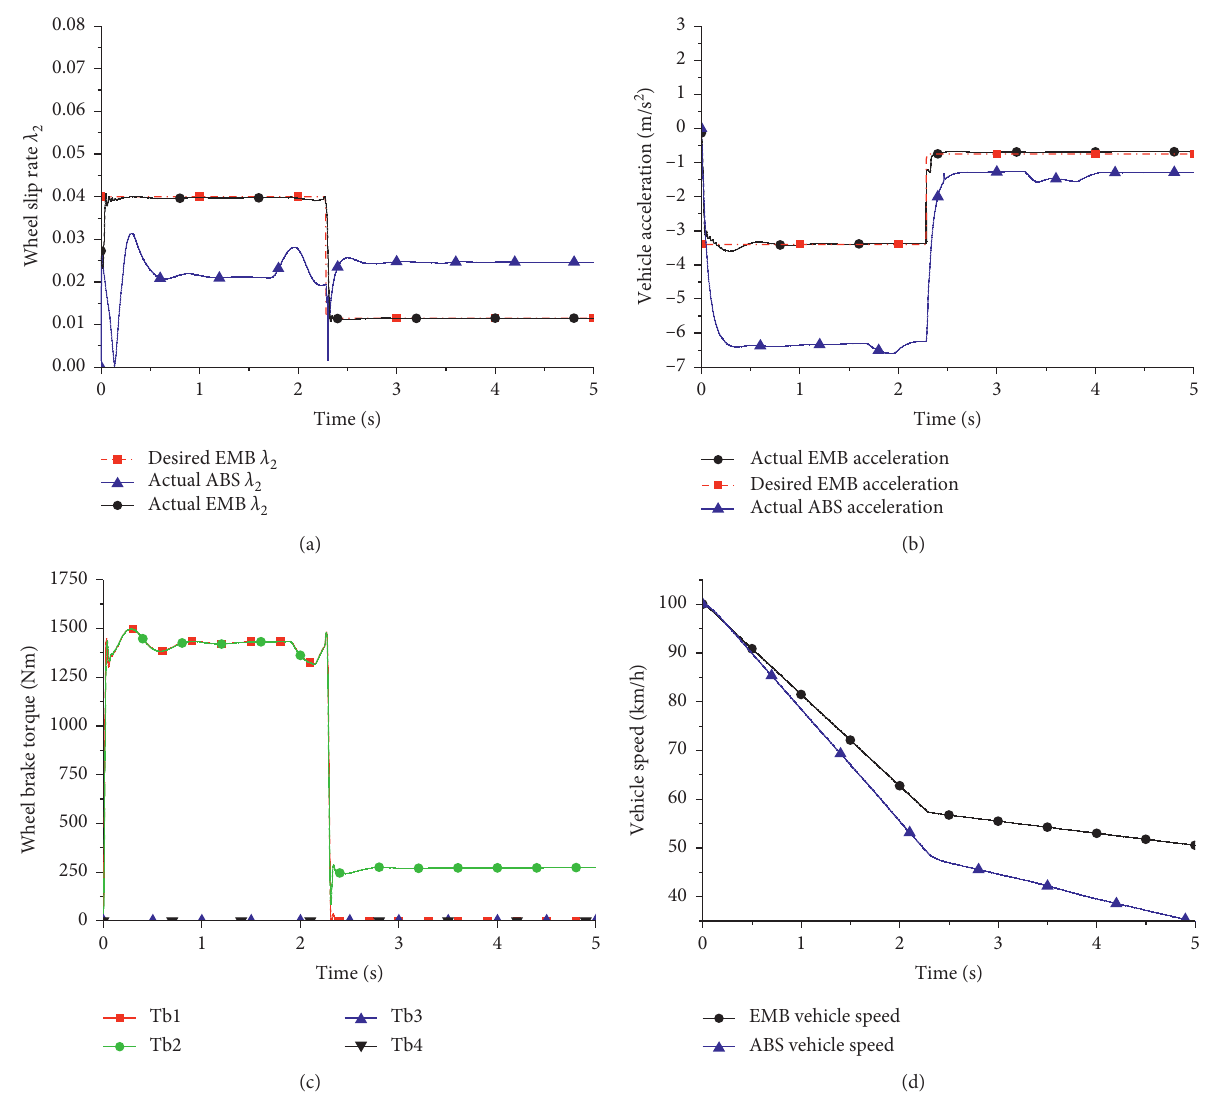
Figure 11: Medium comfort brake, switch wet asphalt pavement to snow-covered pavement. (a) Wheel slip rate. (b) Vehicle acceleration. (c) Wheel brake torque. (d) Vehicle